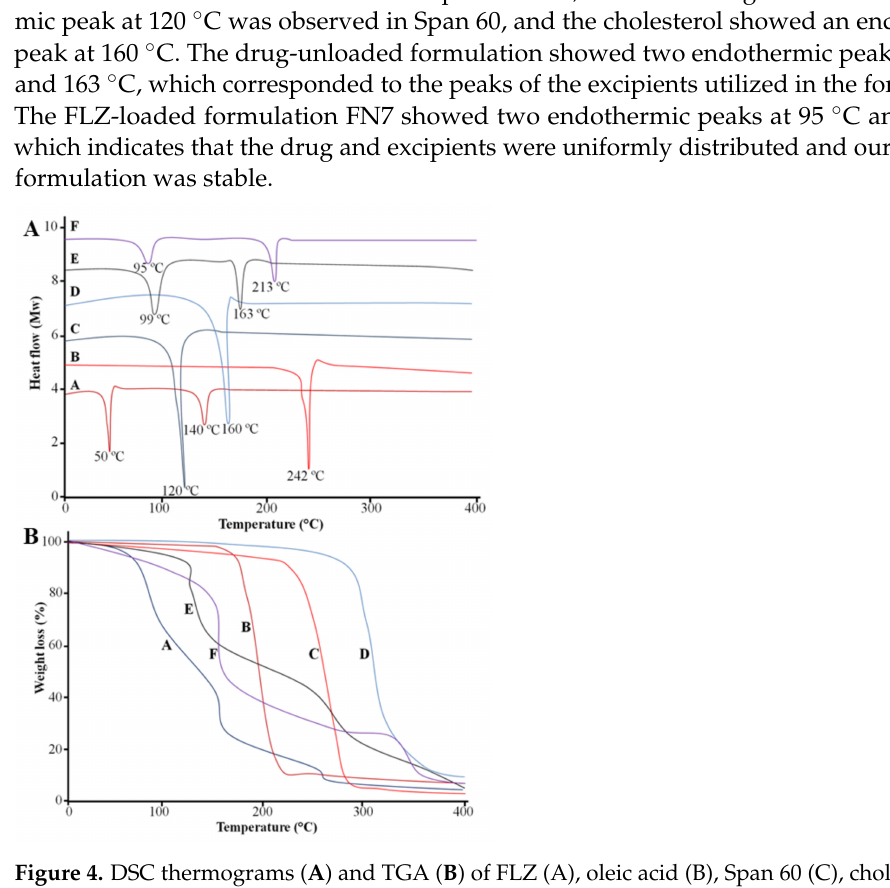
Figure 4. DSC thermograms ( A ) and TGA ( B ) of FLZ (A), oleic acid (B), Span 60 (C), cholesterol (D), blank formulation (E) and FLZ-loaded formulation